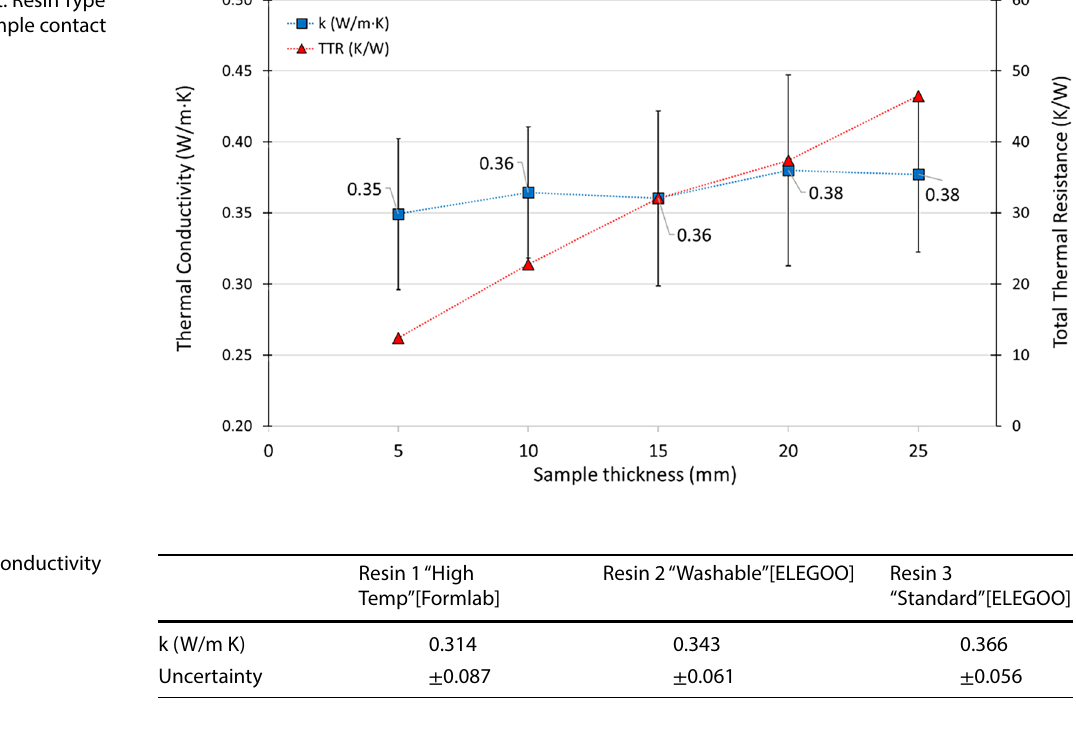
Resin 2 “Washable”[ELEGOO] Resin 3